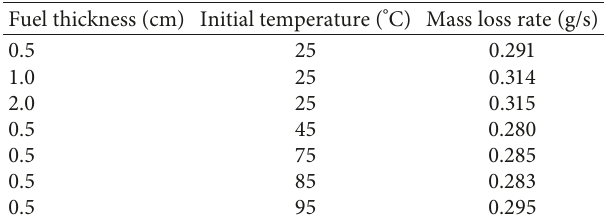
Figure 3: Variations of mass loss rate as a function of time under different experimental conditions, (a) different fuel thicknesses, and (b) different initial temperatures. Table 2: Average values of mass loss rate for different experimental